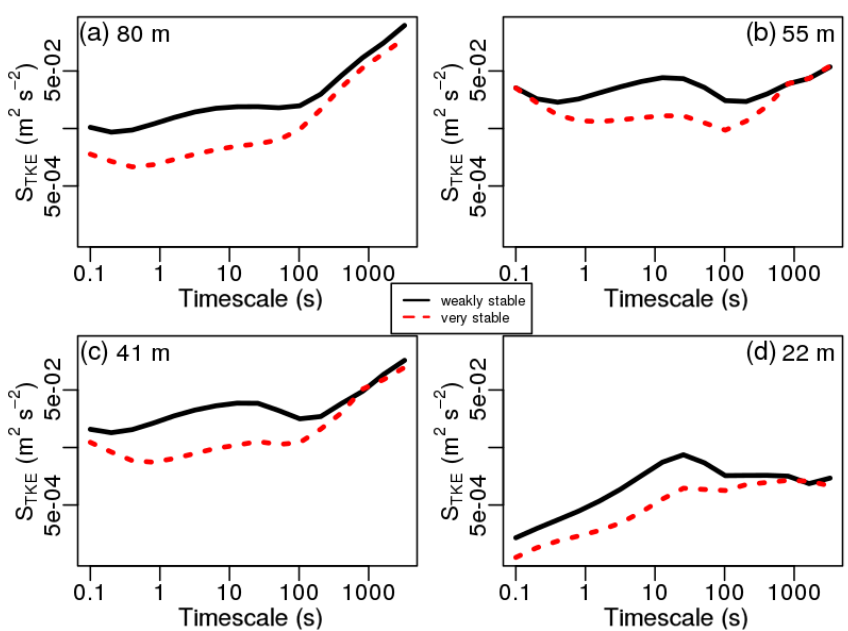
Figure 12. Average TKE spectra for the weakly stable (black solid lines) and the very stable (red dashed lines) cases for all levels, as indicated in each panel. In all panels, averages are calculated for each